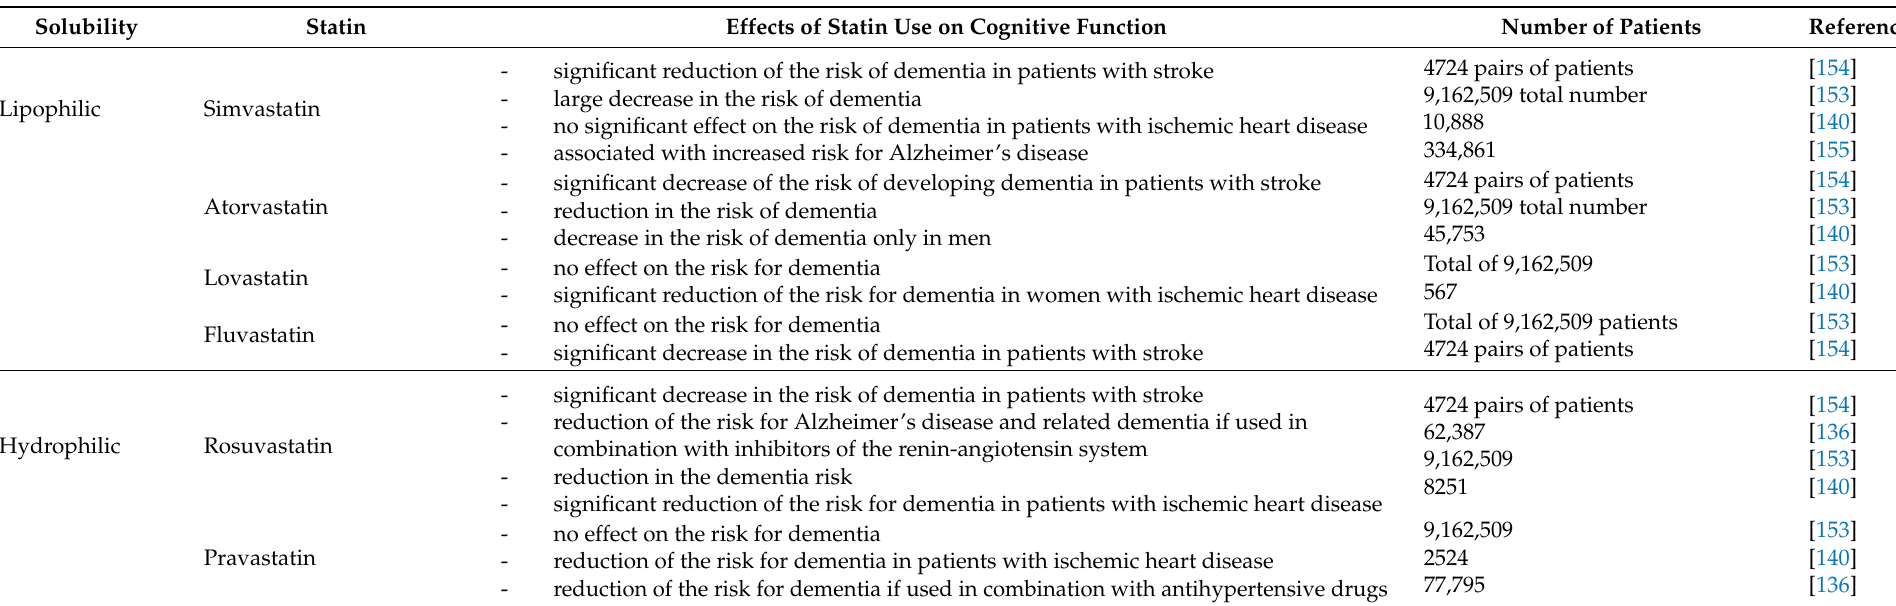
Table 3. Effect of statin use on the risk of developing